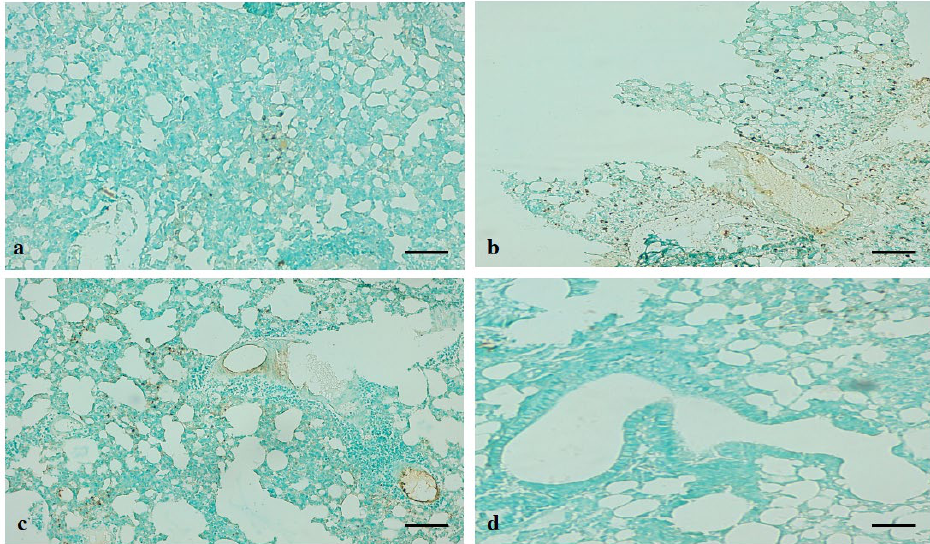
Figure 12. The effect of ADE was analyzed on apoptosis using TUNEL assay. ( a ) in the control group, brown-stained nuclei were not seen; ( b ) significant number was seen in the B(a)P-treated group only ( c ) the group treated with ADE plus B(a)P displayed a significant decrease in the apoptosis ( d ): the group treated with ADE only did not show any brown-stained nuclei (Scale bar = 100 µm).